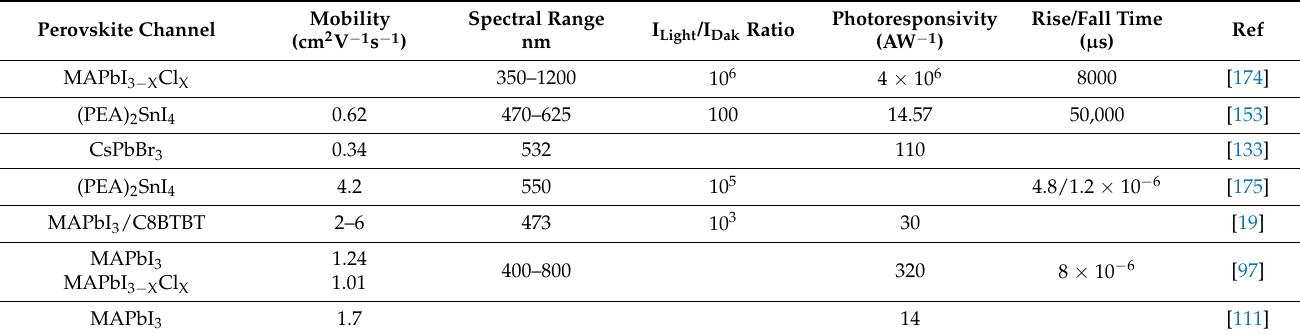
Table 5. All the reported perovskite-based photo FETs and their